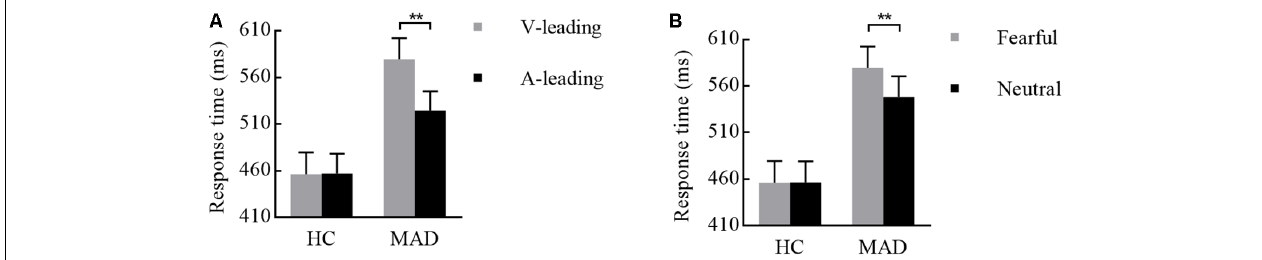
FIGURE 4 | Combination of the results of RT for Experiment 2. (A) For fearful cues, MADs showed a longer RT in V-leading than that in A-leading cues, but HCs did not. (B) In V-leading cues, MADs showed a longer RT for neutral than that for fearful cues, but HCs did not. ** p <